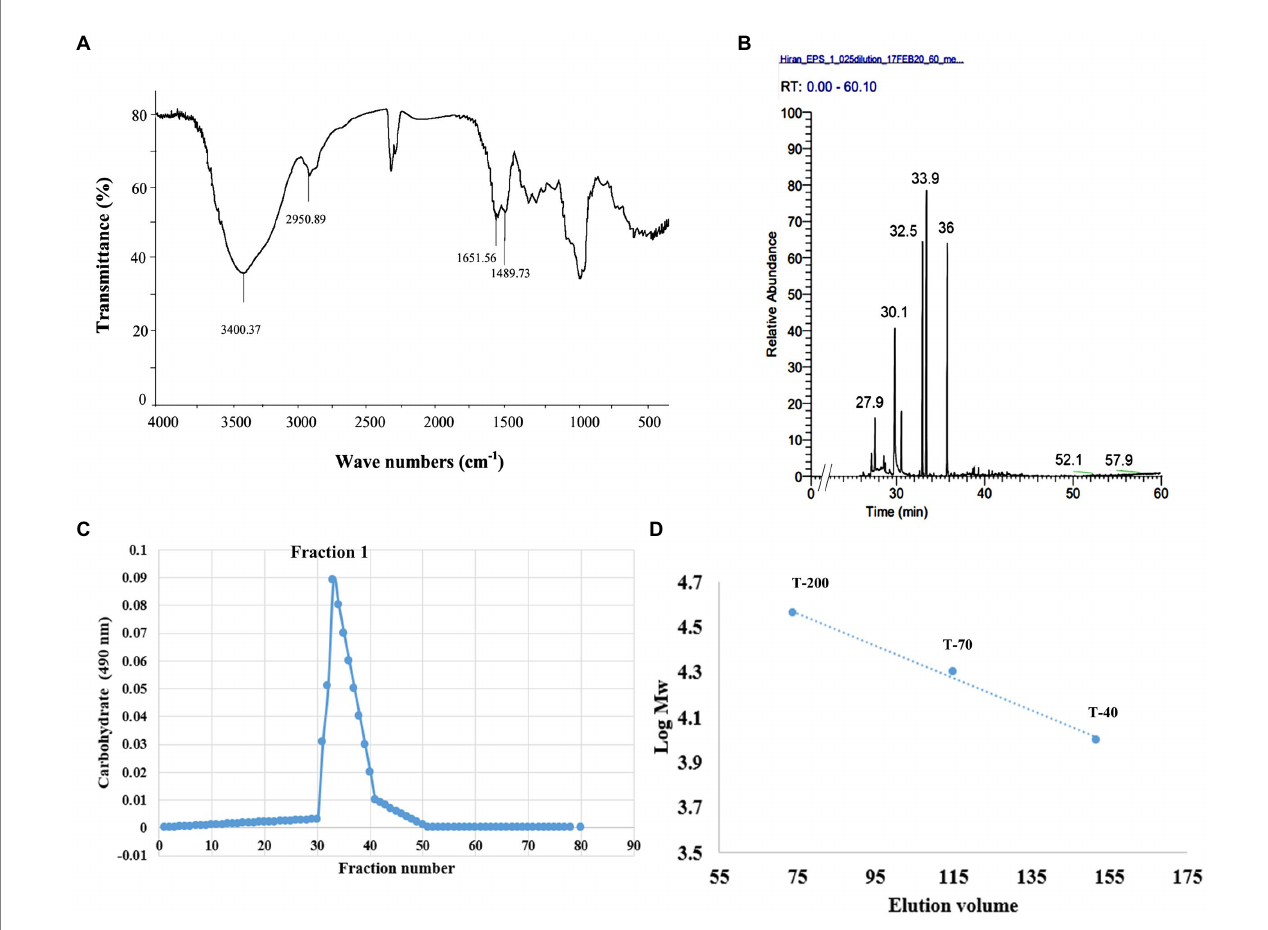
FIGURE 3 (A) FT-IR spectra of crude HELF2 GRH showing the necessary functional groups present in the sample. (B) GC–MS chromatogram of the derivatized fungal GRH showing the different peaks of monosaccharide compositions at different retention times. (C) Elution profile of the polysaccharide showing the